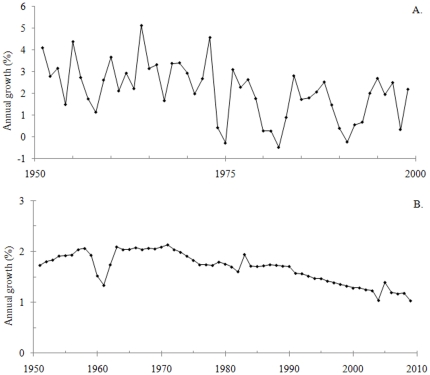
Time series used for testing the statistical meaningfulness definition (continued).A. Annual growth in global aggregate gross domestic product per capita 1951–1999. Data from [14]. B. Annual growth of the global population number 1951–2009. Data from [14].